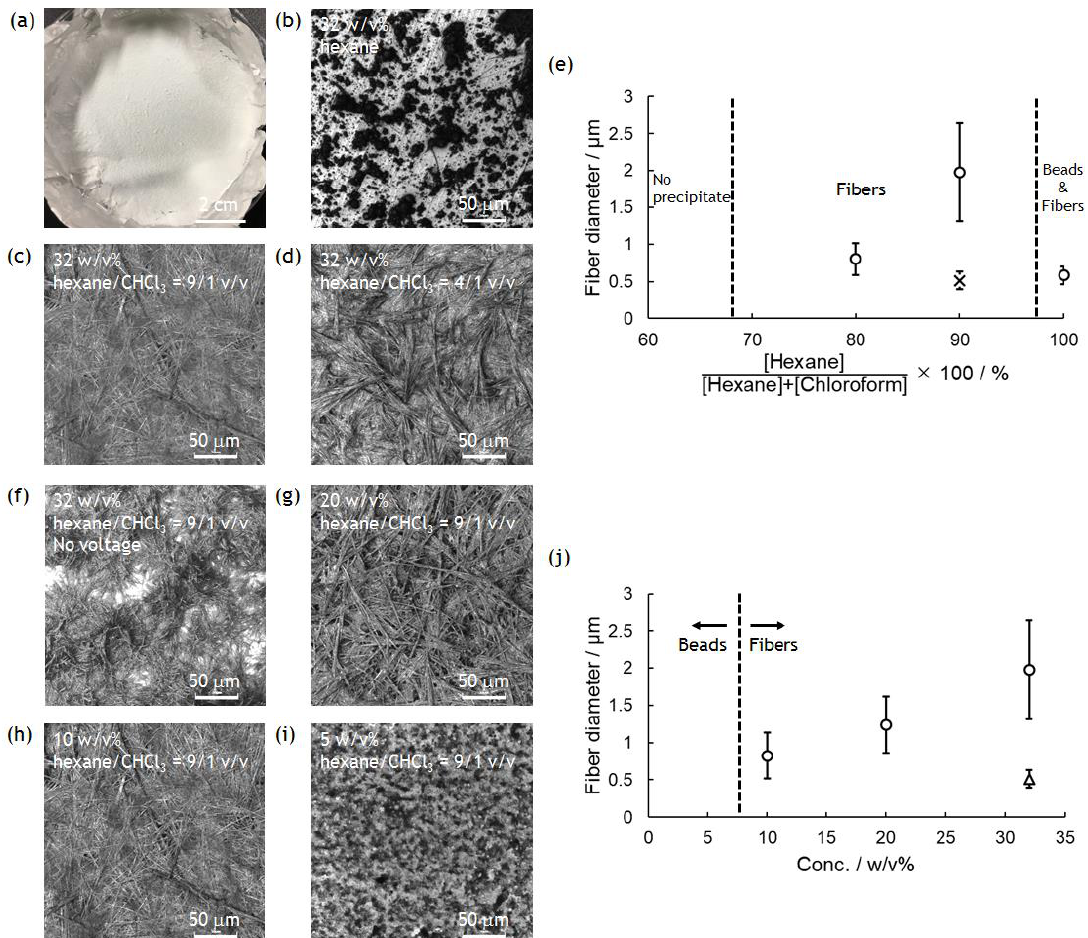
Figure 2. Electrospinning of PolyPhe in TFA/CHCl 3 (9/1 v / v ) into hexane/CHCl 3 (10/0, 9/1, 4/1 v / v ). PolyPhe conc. was 32, 20, 10, or 5 w / v %. ( a ) A typical photograph of PolyPhe nonwovens collected on the aluminum foil. ( b – d , f – i ) LM images of the electrospun PolyPhe constructs. The voltage was ( b – d , g – i ) 5 kV and ( f ) 0 kV, solution speed was 0.5 mL/h, and collection distance was 3 cm. ( e ) Solvent composition vs fiber diameter. PolyPhe conc. was fixed at 32 w / v %. ( j ) PolyPhe conc. vs fiber diameter. The solvent was hexane/CHCl 3 (9/1). The diameter was calculated from SEM images of three different samples ( n = 50). A cross in ( e ) is the value calculated from the image ( f ). A triangle in ( j ) is the value calculated from the cast film.